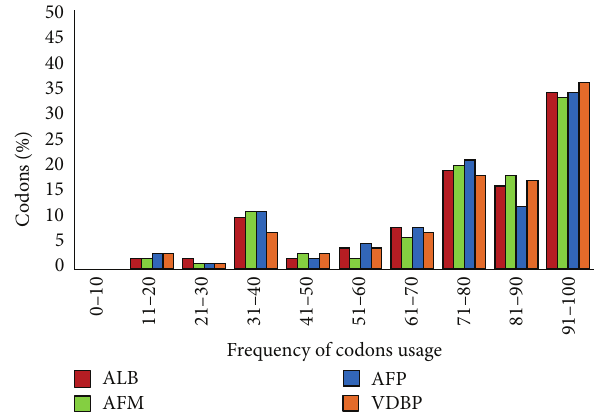
Figure 2: Codon frequency distribution of human albumin super- family